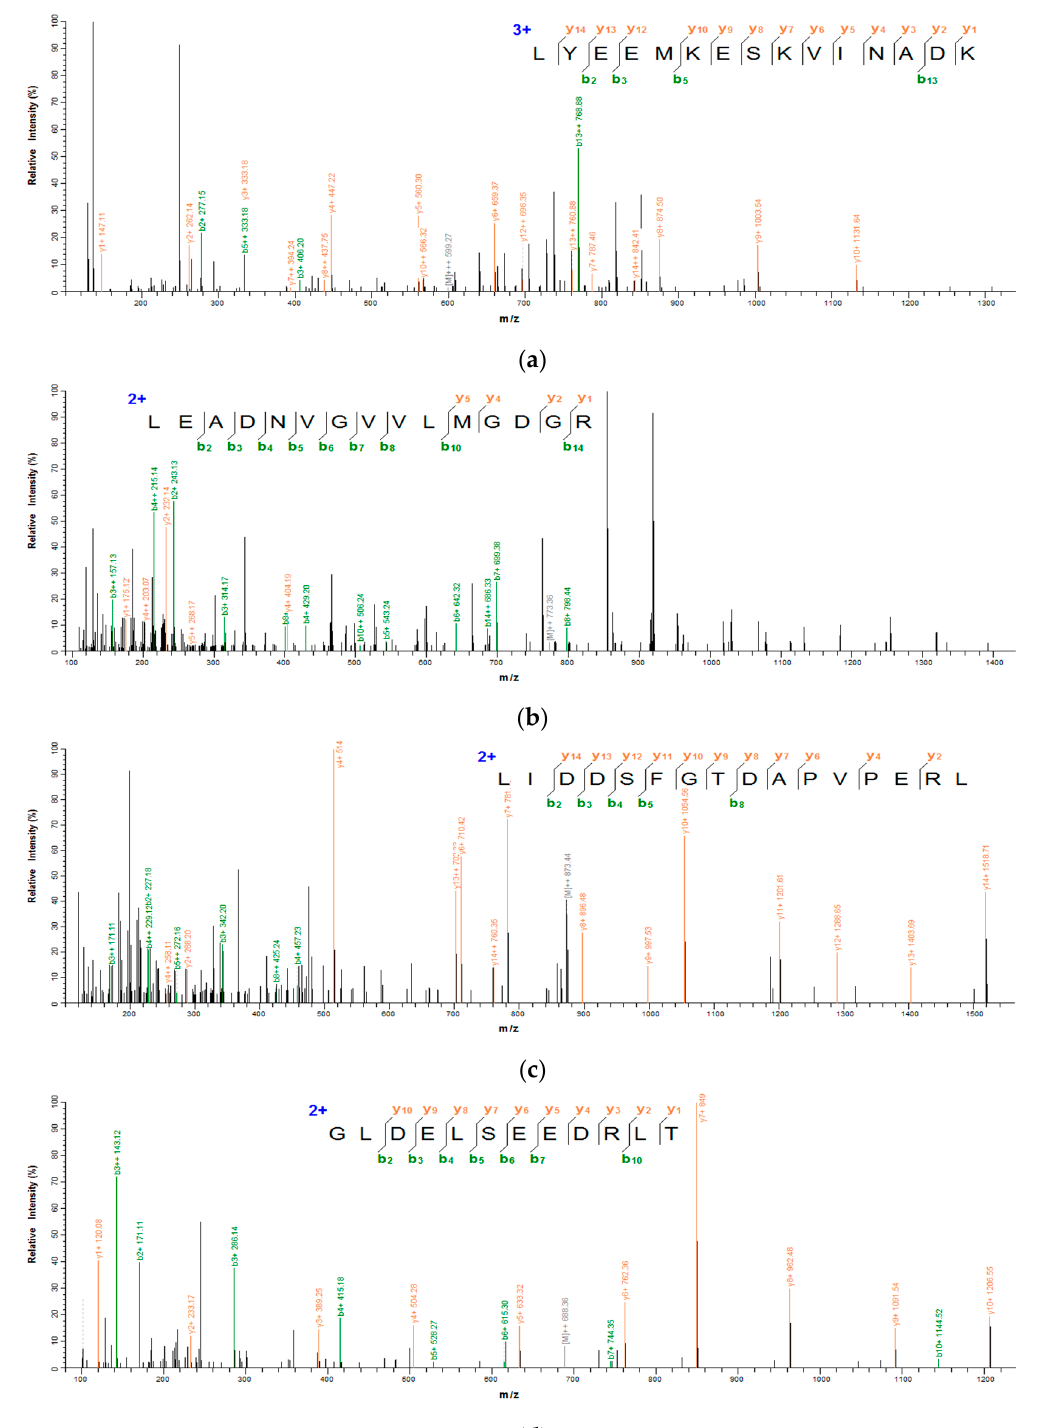
Figure 4. Secondary mass spectrum of antioxidant peptides from G. livida . ( a )